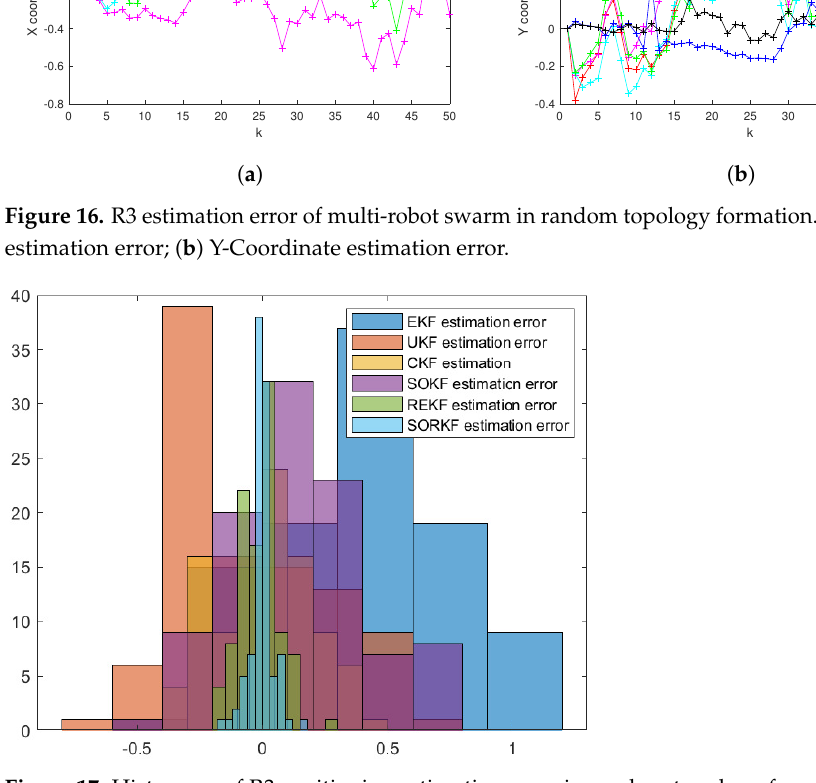
Figure 17. Histogram of R3 positioning estimation error in random topology